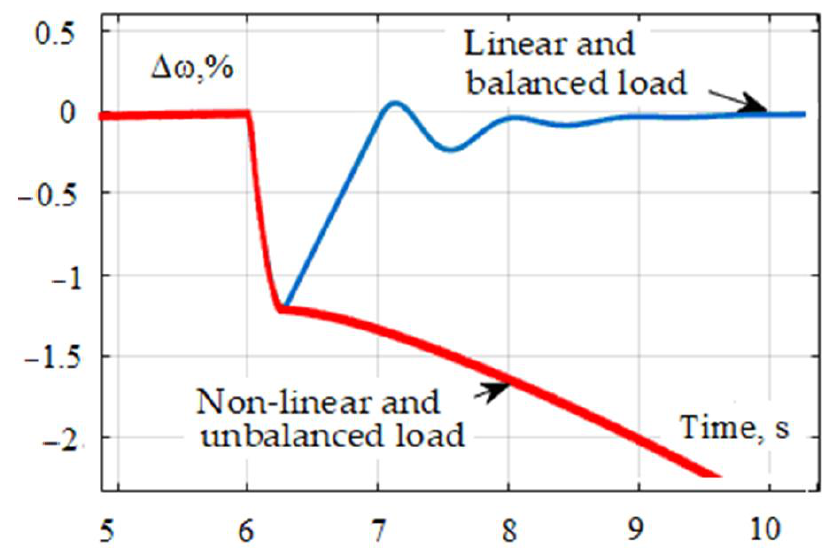
Figure 23. Waveforms of generator rotor speed deviation when an additional load was connected.